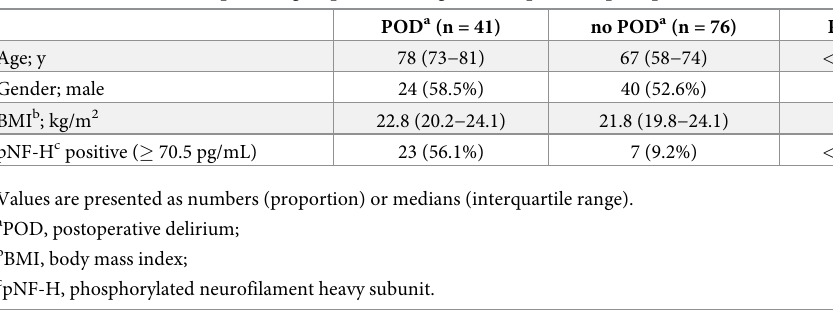
PLOS ONE | https://doi.org/10.1371/journal.pone.0259217 November19,